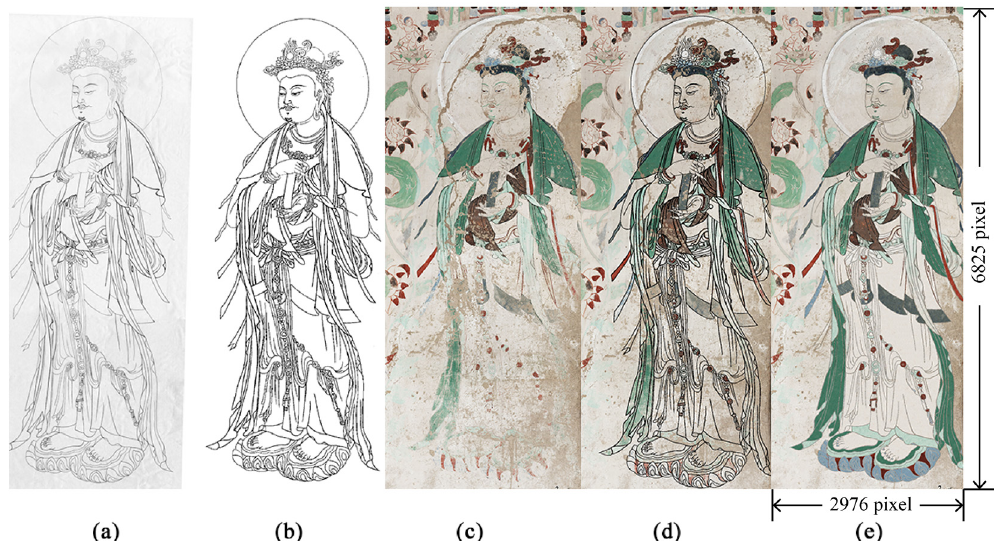
Figure 4. (a) Original line drawing on Chinese rice paper; (b) digitalized line drawing after pre-processing; (c) photo of original mural; (d) alignment of line drawing and mural image; (e) restoration result.